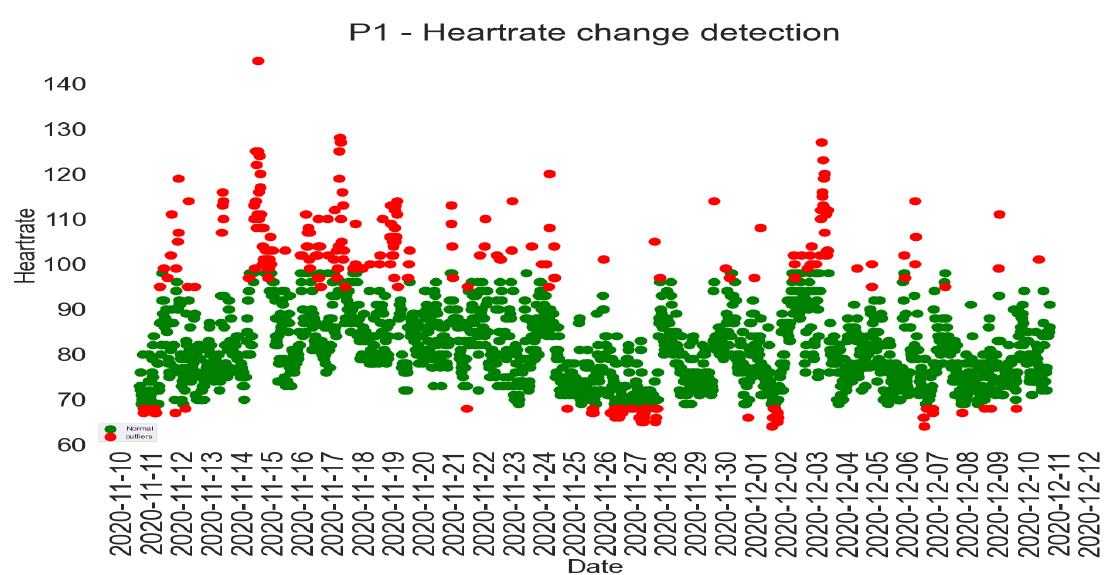
Figure 23. Heart rate Change detection.